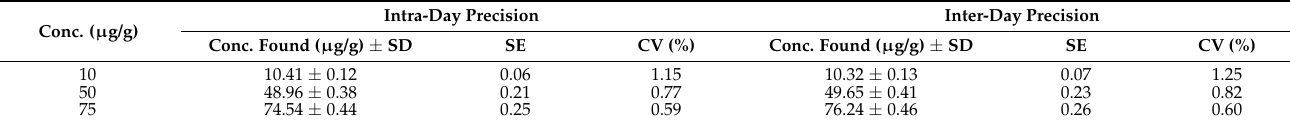
Table 5. Intra-day and inter-day precision of PTT for HPLC approach (mean ± SD; n = 3).